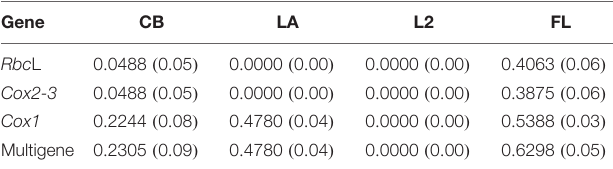
TABLE 5 | Gene diversity (Nei) of Botryocladia occidentalis in three distant regions in the Gulf of Mexico, measured as the probability of obtaining different haplotypes in two randomly drawn individuals